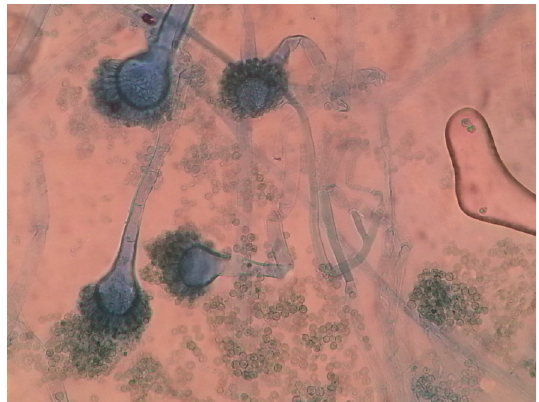
Figure 5: Confirmation of Aspergillus niger with the specific phenotypic characterization of conidiophores, vesicles, metulae, biseriate phialides, and conidia in the LPCB mount, observed under a 100X Olympus CX21 compound